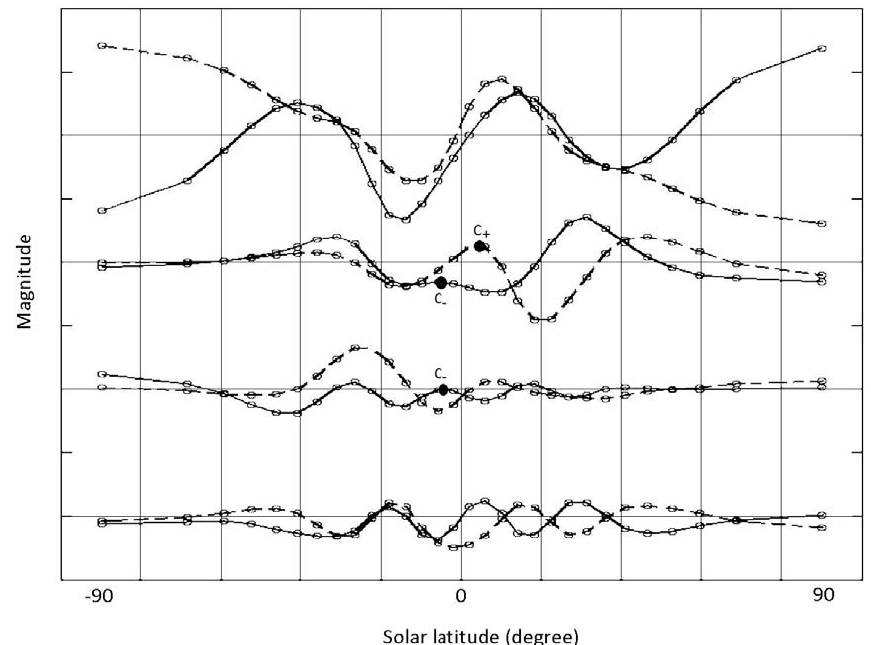
Fig. 1. The latitudinal SBMF distributions in the total set of cycles 21–23 (upper plot), in the separate sets for the cycle 21, cycle 22 and cycle 23 (from the top to the bottom, respectively). Different components in each pair are shown by the solid and dashed lines. The points C − and C + demonstrate the centres of symmetry of the curves describing the SBMF waves, which roles are discussed in Sects. 4.4 and 4.5.